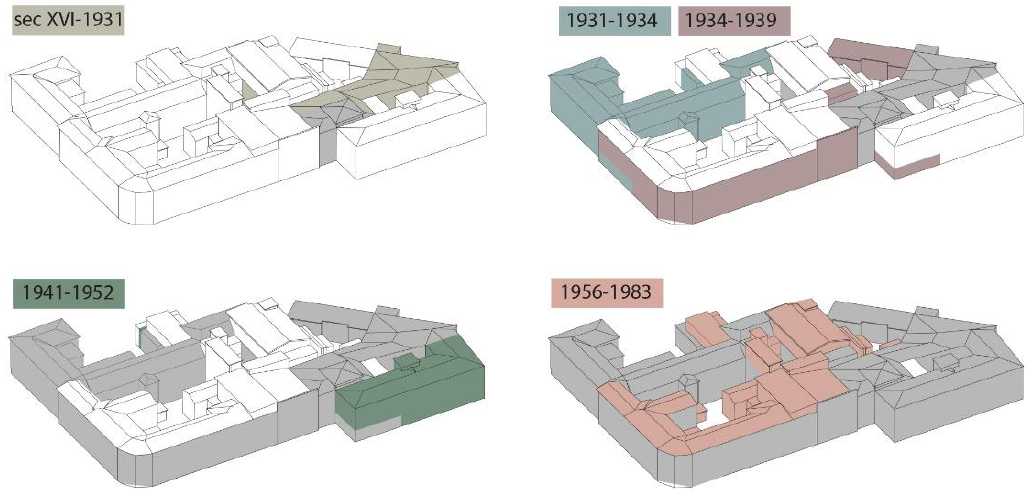
Figure 3. Historical evolution of the architectural complex.